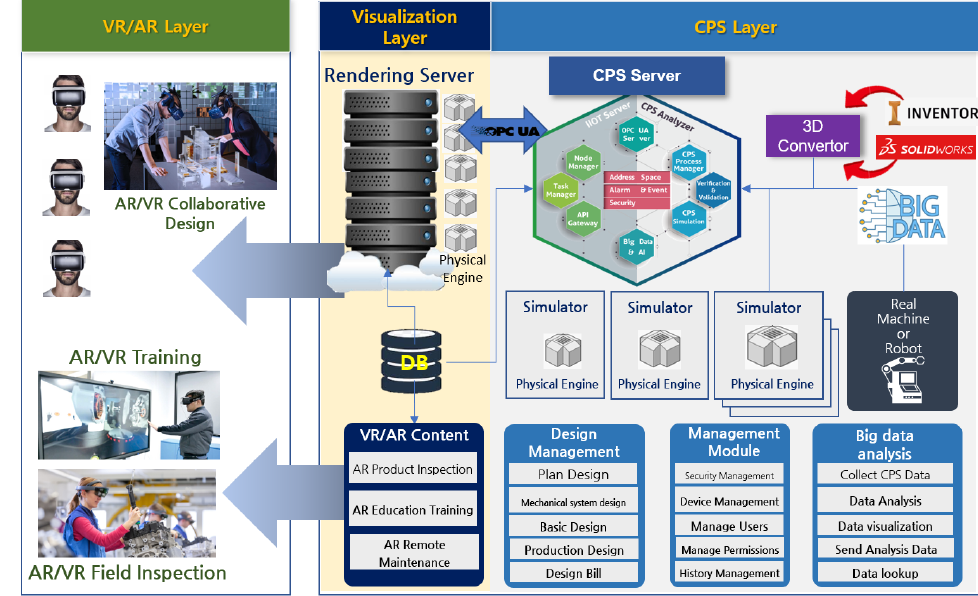
Figure 2. VR/AR collaborative